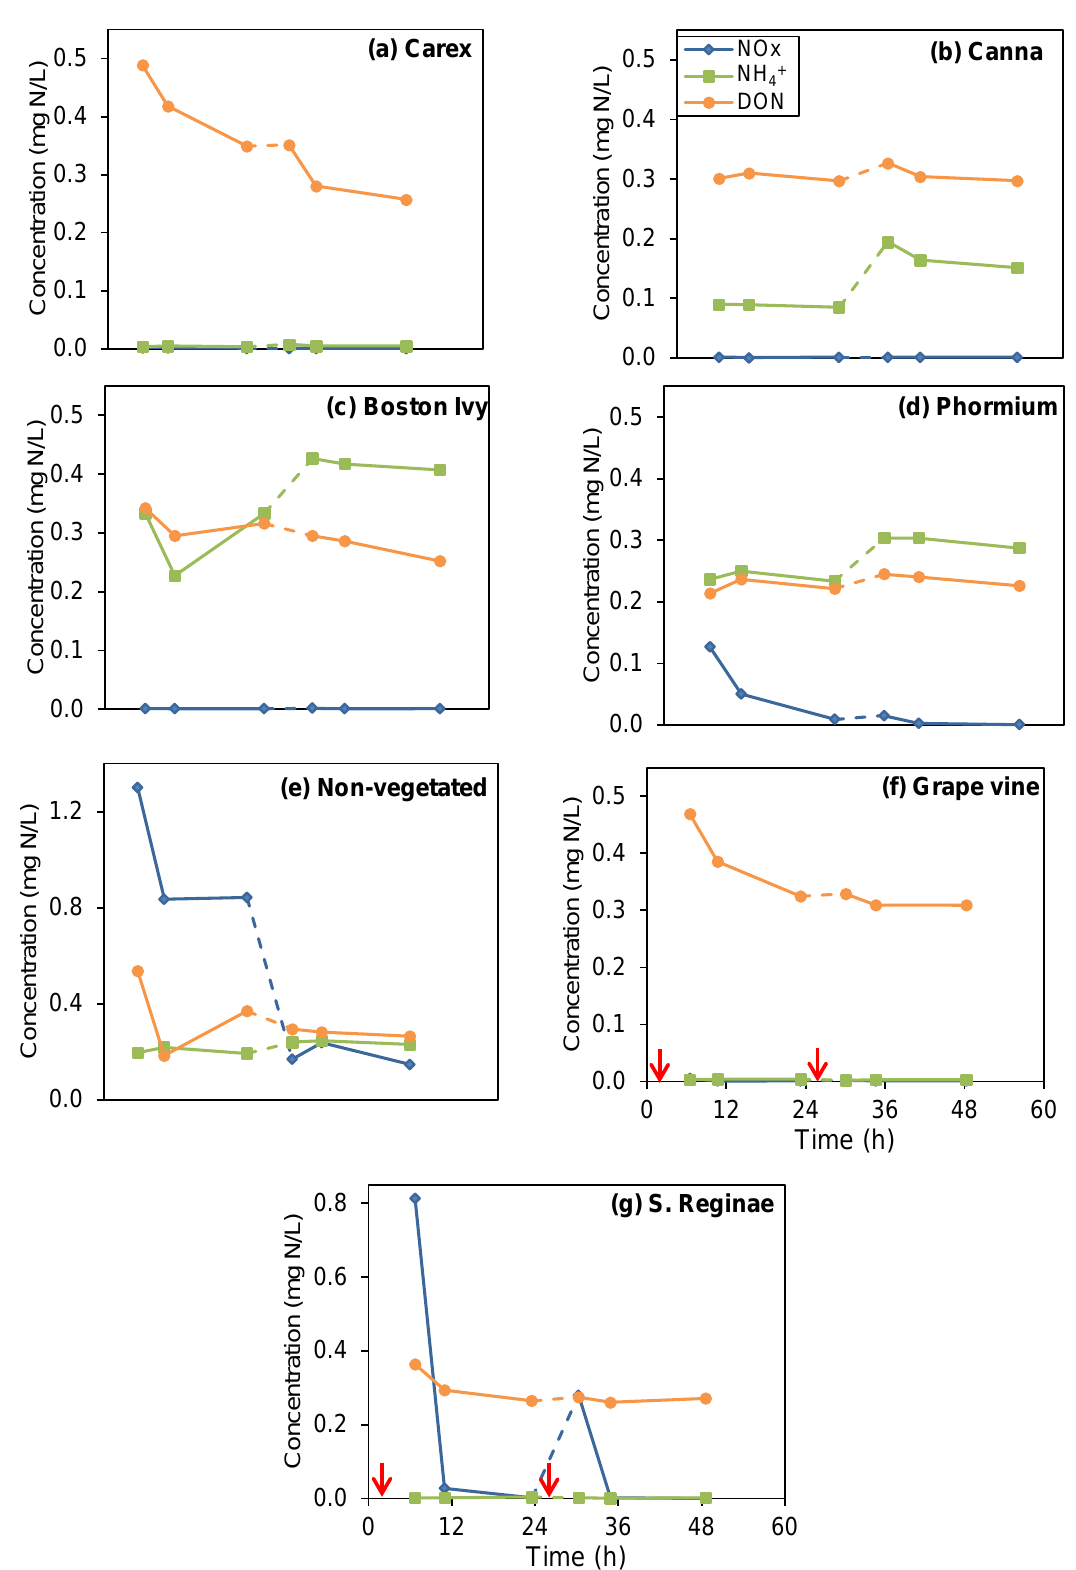
Figure 3. Variation of concentrations of DON, NH 4+ , and NO x in saturated zone pore water over time in October 2015: ( a ) Carex appressa ; ( b ) Canna lilies; ( c ) Boston Ivy; ( d ) Phormium ; ( e ) Non-vegetated control; ( f ) Grape vine and ( g ) Strelitzia Reginae . Red arrow denotes dosing at 0 h and 24 h. Columns planted with grape vine and S. Reginae (novel SZ design) were supplemented with sodium acetate as external carbon source.